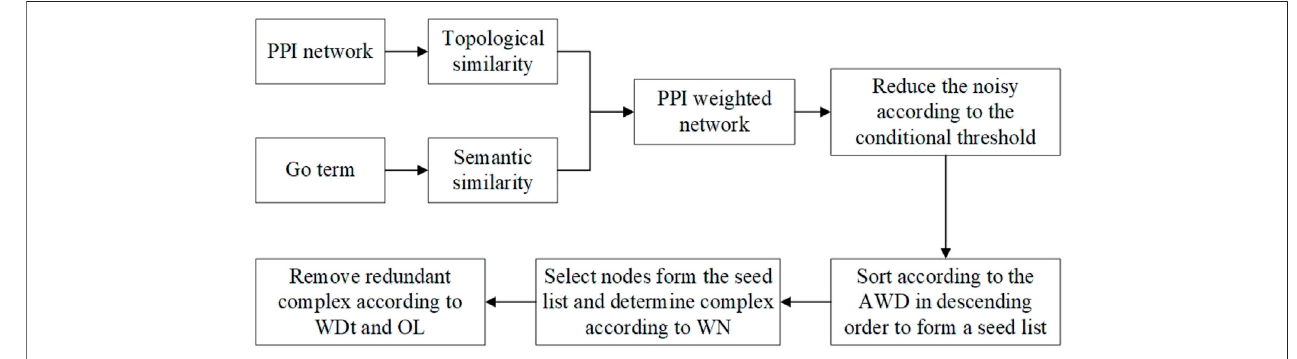
FIGURE 1 | Work fl ow of the NNP.